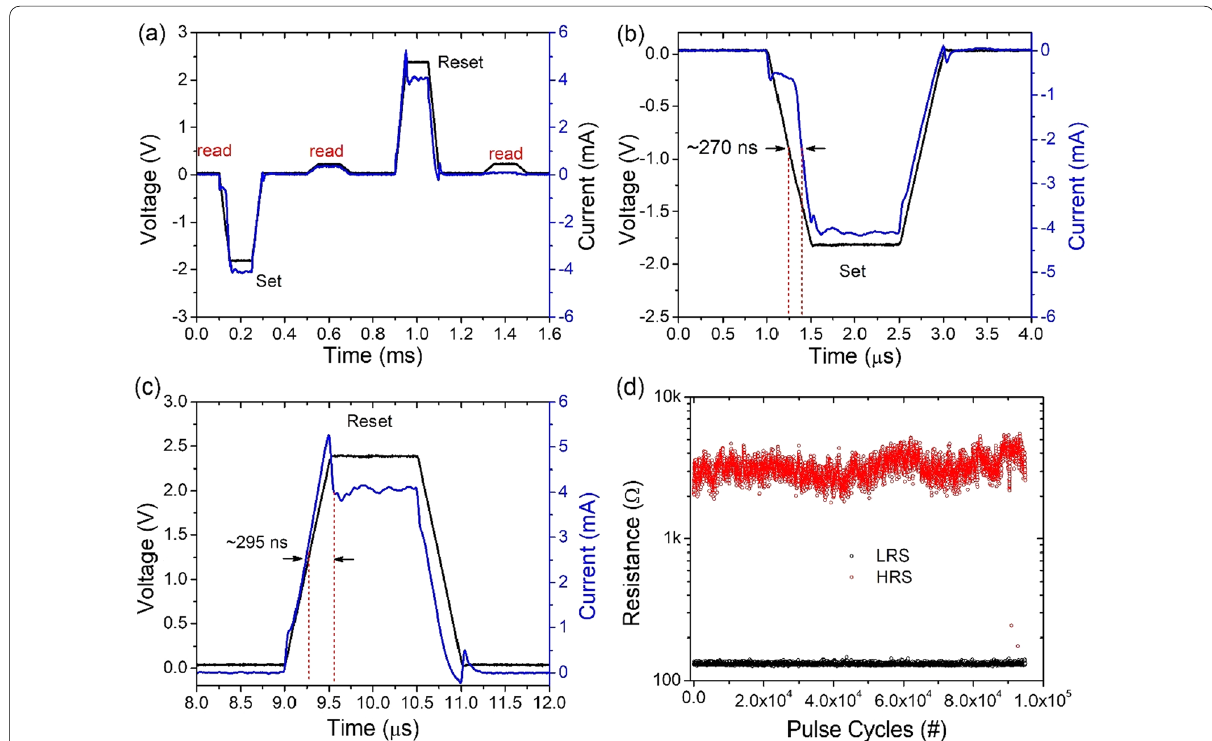
Fig. 6 Pulse response characteristics of the Pt/HfO 2 /Al 2 O 3 /TaN memristive device: a current response during set and reset process under negative and positive bias pulses, respectively. b Set response time is about 270 nm and c Reset response time is about 295 ns, which are represented by red dashed lines. d Pulse endurance test. Device switched with 10 difference in HRS and LRS and suffered no read/write disturbance after more than × 10 5